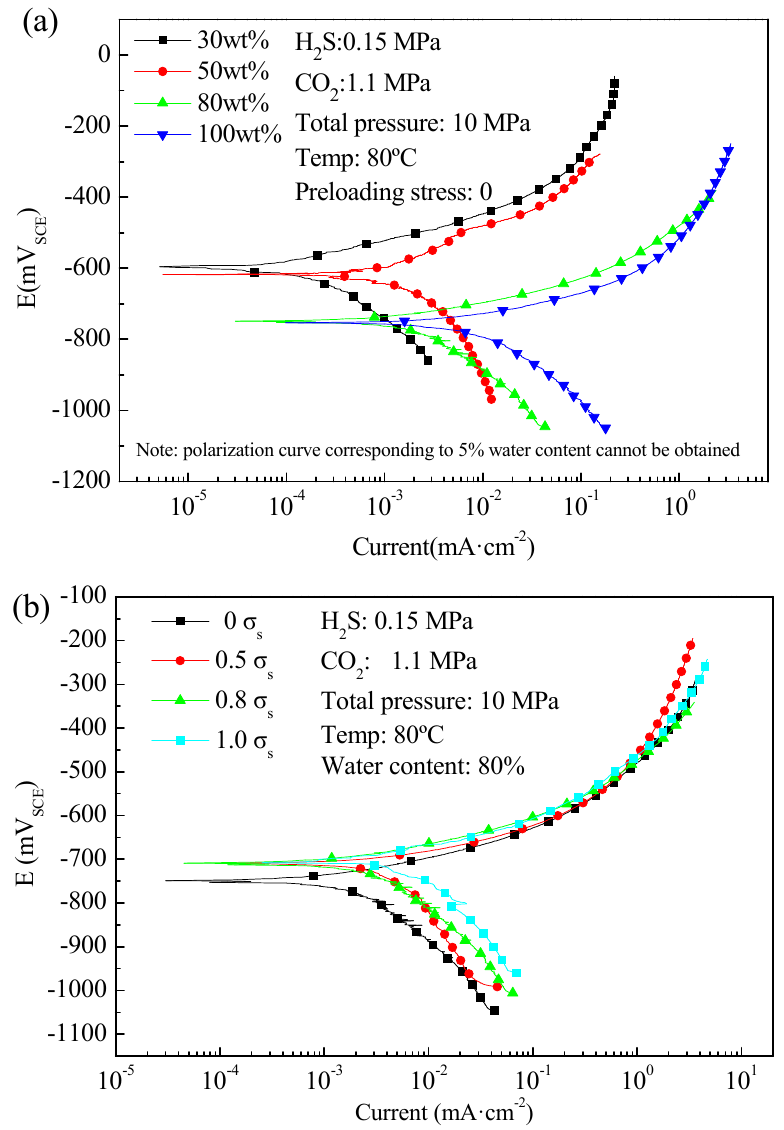
Figure 4. Potentiodynamic polarization curves of L80 steel measured under different: ( a ) water contents; and ( b ) preloading stresses.